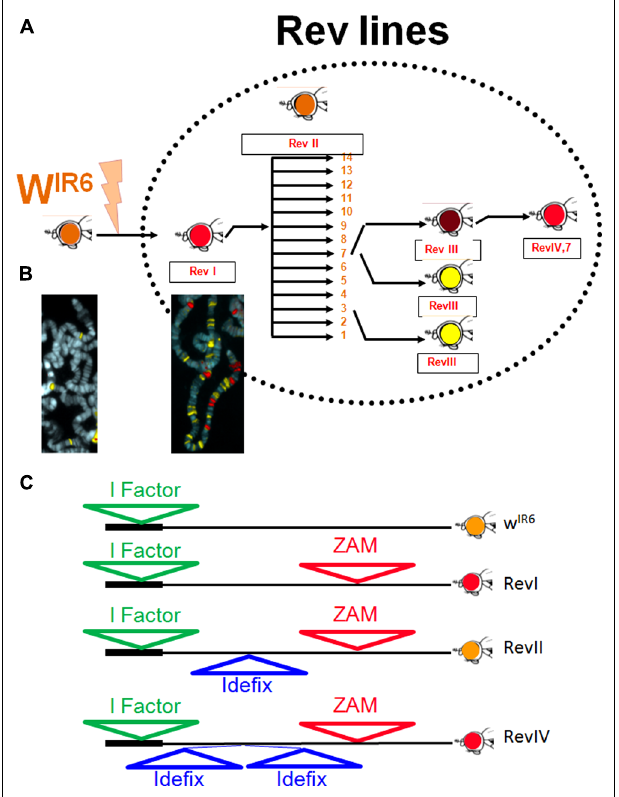
FIGURE 1 |The Rev line: (A) History of the unstable line, Rev, recovered after a PM mutagenesis performed on the w IR6 line. In Rev, recurrent mutations affecting the eye color are recovered giving rise to derived lines successively called RevI, RevII, RevIII, and RevIV. (B) FISH mapping of ZAM (red) and Idefix (yellow) in w IR6 (left) and Rev (right). (C) Molecular structure of different alleles of the white gene recovered in the Rev